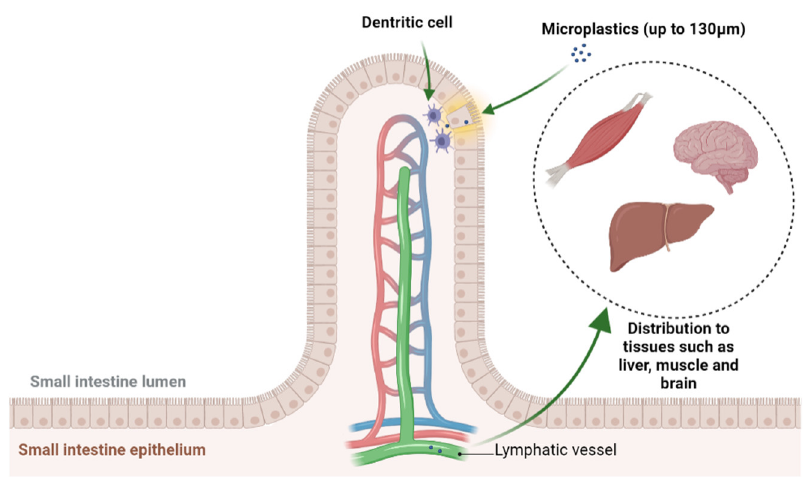
Figure 7. Crossing of microplastics in the digestive tract. Created with BioRender.com.